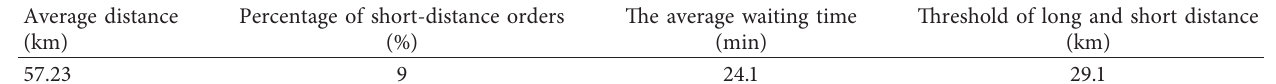
Table 17: The optimized calculation results from the airport to urban in